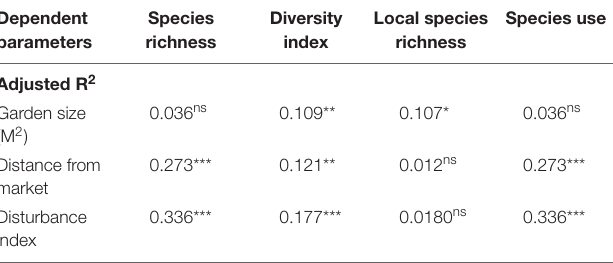
( Figure 6 and Supplementary Figure 1